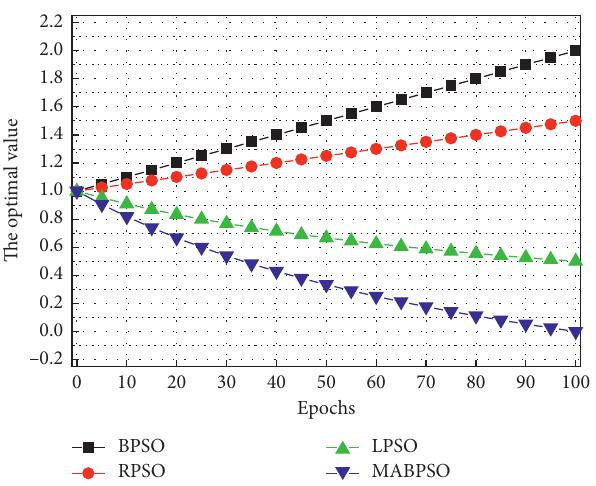
Figure 8: Convergence curve.